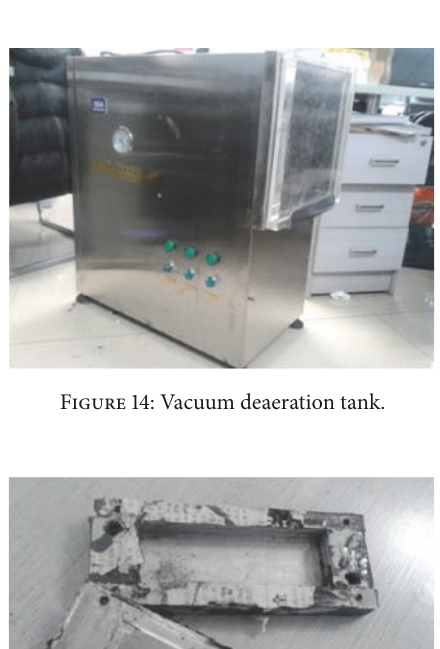
Figure 13: Static magnetic field device.